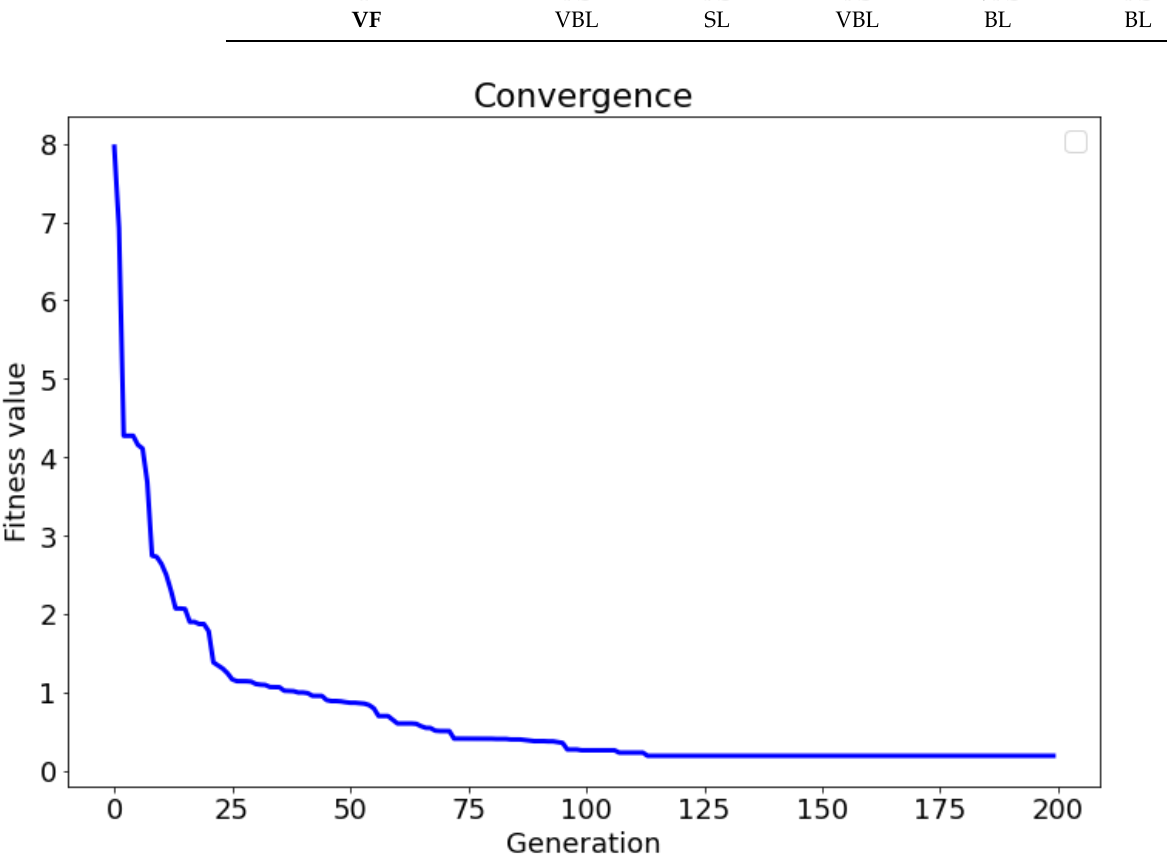
Figure 13. The convergence of the fitness value over generations.